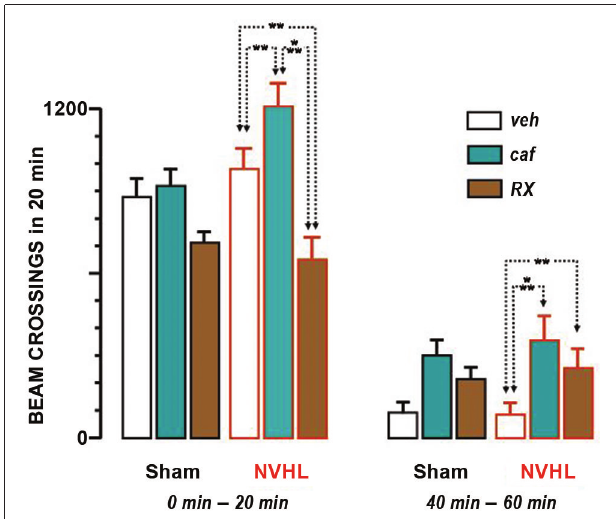
FIGURE 2 | Locomotion under drug or vehicle . Bar graphs represent means + S.E.M. of the beam crossings during 20 min. The 6 bars on the left hand side represent the initial 20 min of the test. The 6 bars on the right hand side represent the last 20 min. In each group of 6 bars, the 3 left ones were obtained with sham-lesioned rats and the 3 right ones with NVHL rats (as indicated below the bars). The white bars represent the effect of the vehicle, the green one of caffeine and the brown one for RX821002. The dotted lines ending with two arrows indicate the differences between the groups that were statistically significant (** p < 0.01; *** p < 0.001).